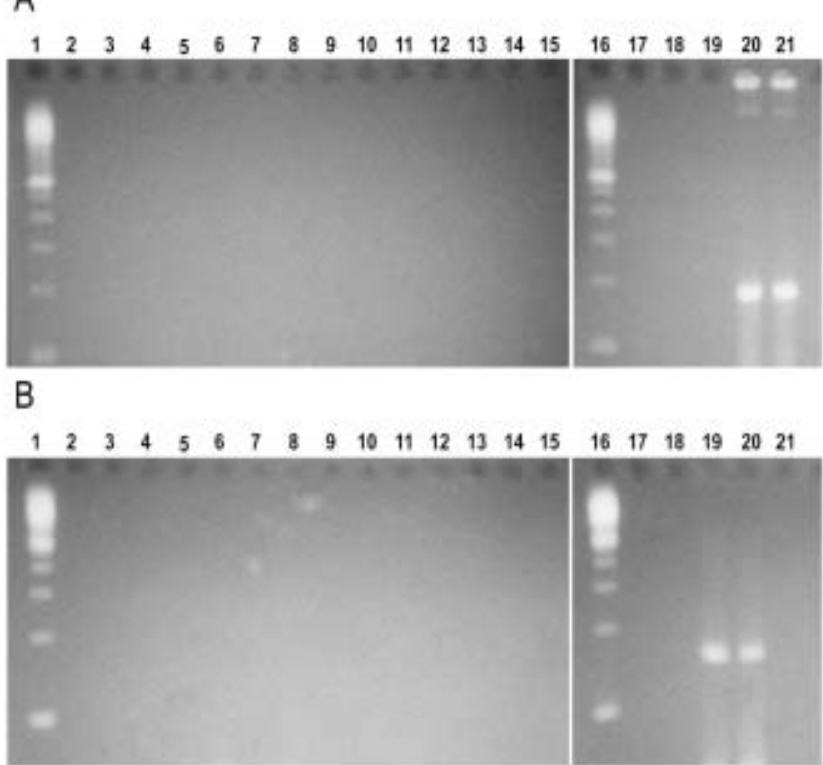
Figure 2 Results of real-time PCR were confirmed with agarose gel electrophoresis of PCR products. No amplification was observed for (A) GBS negative samples (A lanes 2–15 and 17) or (B) E. coli negative samples (B lanes 2–15 and 20–21). Negative control (PCR water, A18 and B19) tested appropriately. Positive control and spiked sample for GBS (A19–20) yielded the 153 bp amplification product whereas positive control and spiked sample for E.